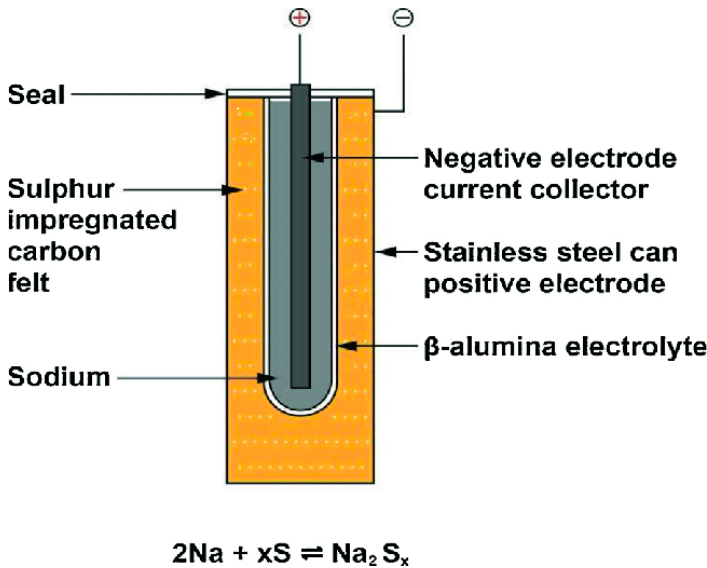
Figure 8. Chemistry and principal components of a sodium–sulfur battery.